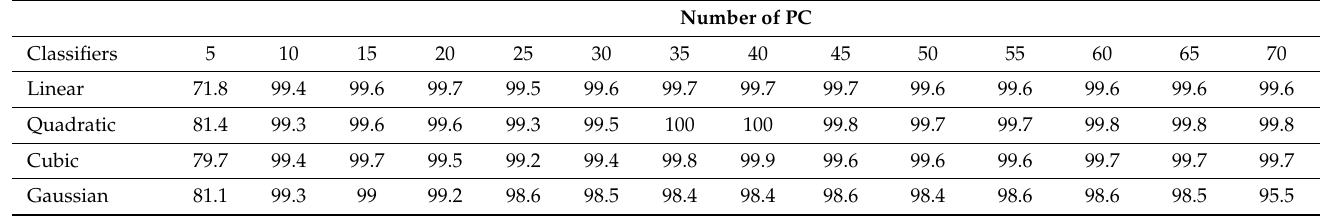
Table 3. The confusion matrices for the linear, quadratic, cubic, and gaussian SVMs trained with the fused DL features and the combined handcrafted features via